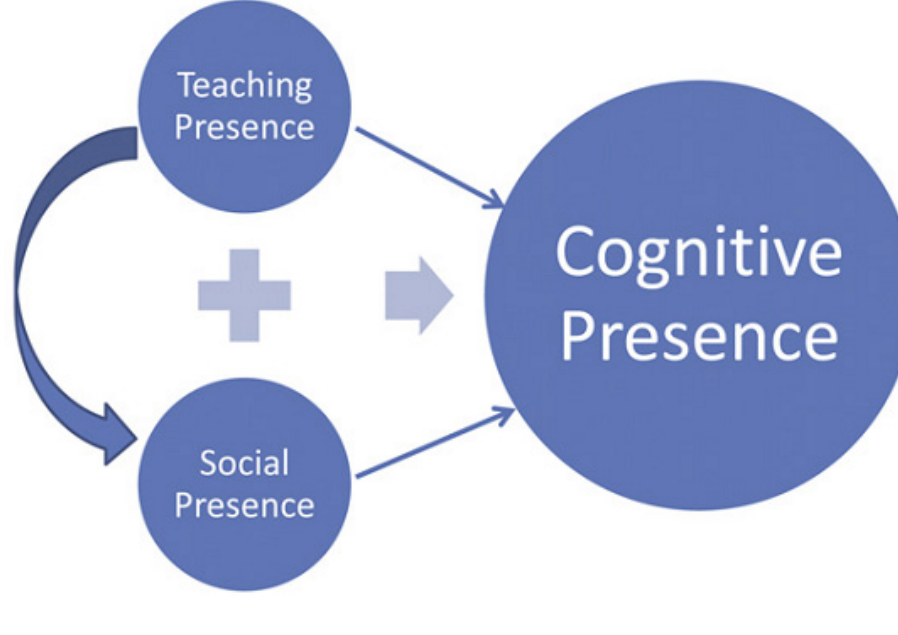
Figure 2 . Relationship between teaching, social, and cognitive presences (Shea & Bidjera - no,